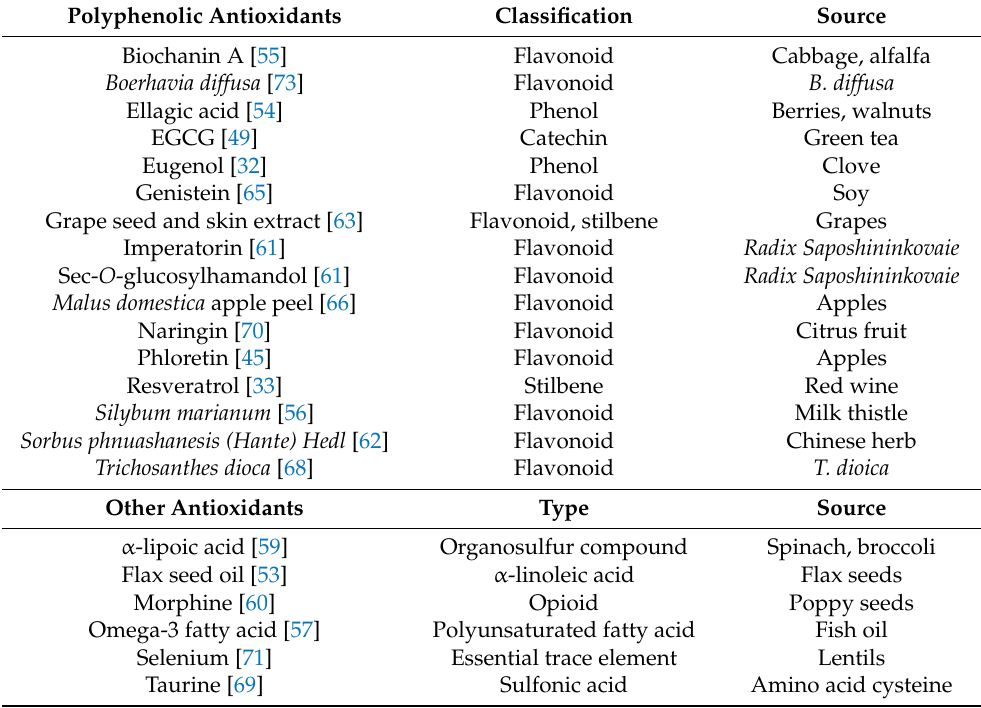
Table 2. Antioxidant classification and source.